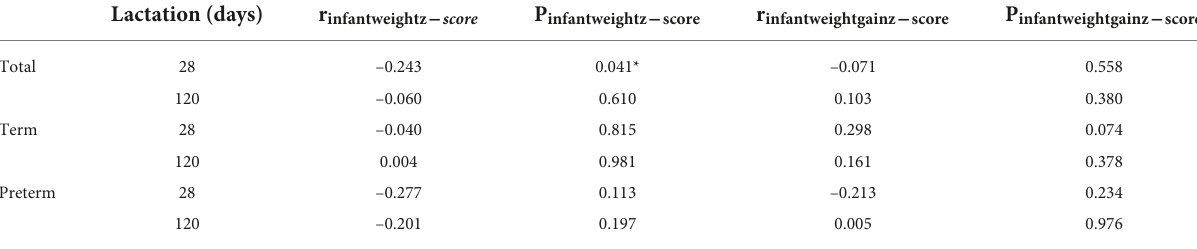
TABLE 3 Pearson correlation between LPN Levels and infant